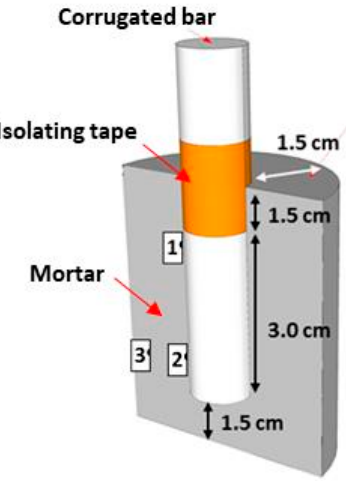
Figure 1. Scheme of the reinforcing mortar samples used in the study.